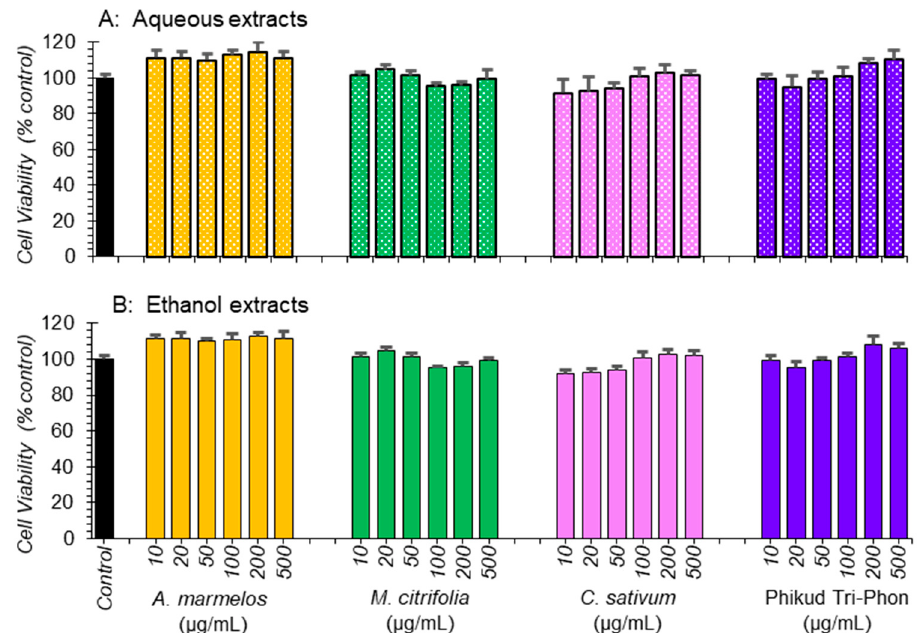
Figure 2. Cytotoxicity of ( A ) aqueous and ( B ) ethanol extracts of A. marmelos, M. citrifolia , C. sativum , and PTP water ( A ) and ethanol extracts ( B ) testing the viability of 3T3-L1 cells. Cytotoxicity was measured using the MTT assay, and the results are expressed as means ± SEM ( n = 3). Responses are expressed as % of corresponding controls.